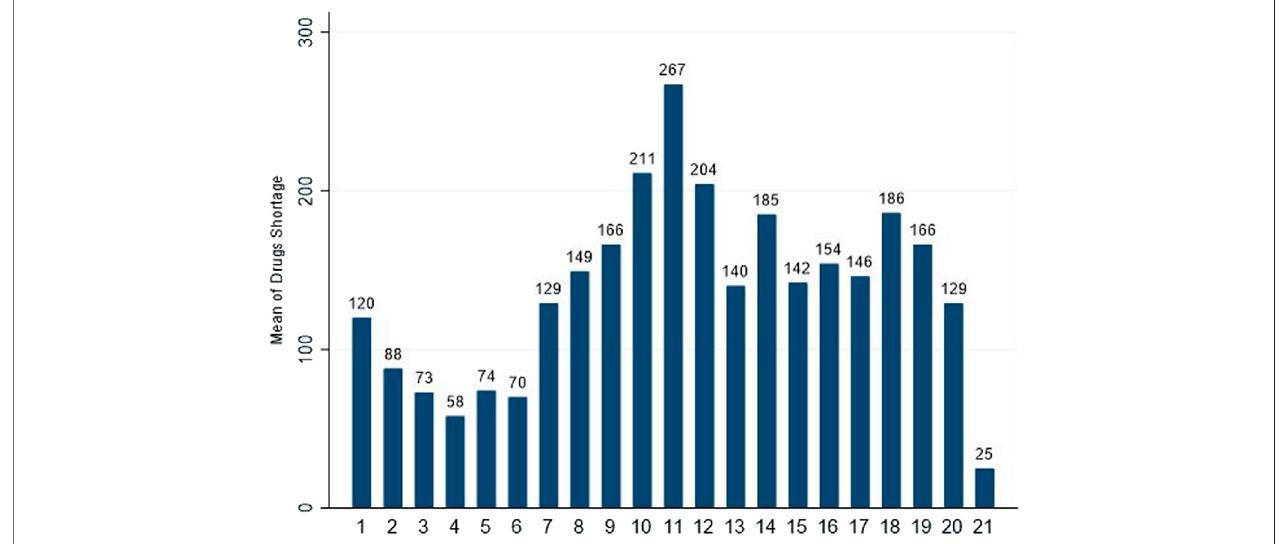
FIGURE 1 | Number of drugs in shortage per year reported by University of Utah Drug Information Services (UUDIS) (American Society of Health System Pharmacists, 2020, June 30).